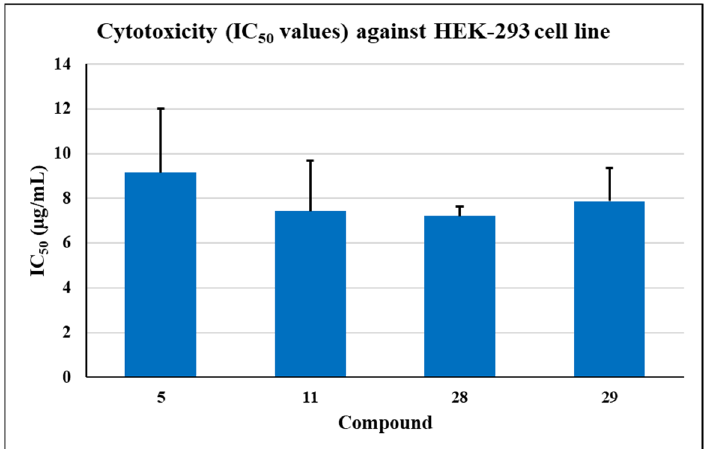
Figure 2. Cytotoxicity of potent antimicrobials for human embryonic kidney (HEK-293) cells. The data show the average of the IC 50 values obtained from triplicate assays for each compound. Error bars indicate the standard deviation values ( n = 3).